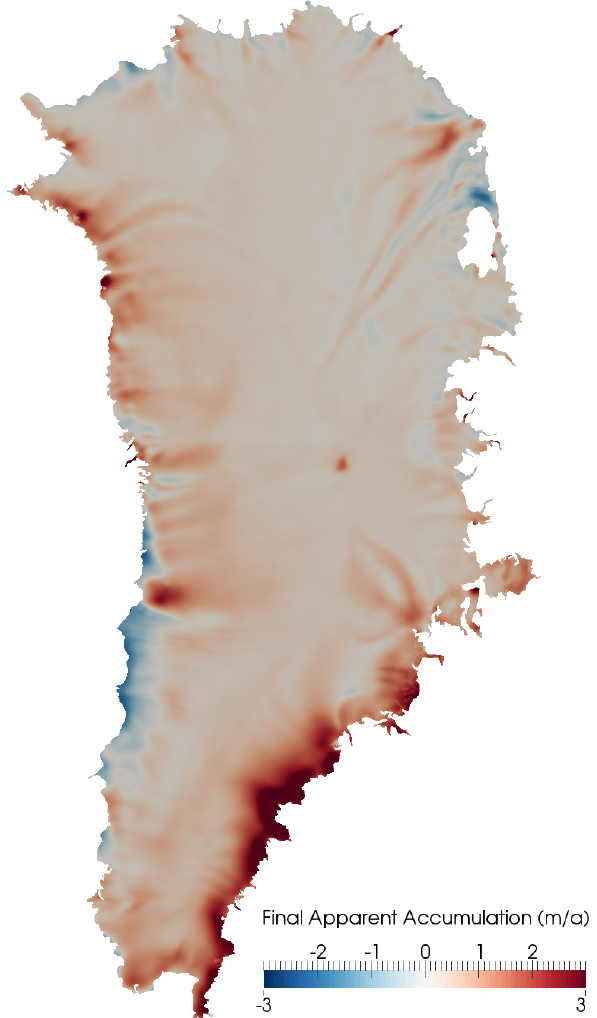
Figure 6. Apparent surface mass balance determined at the end of the optimization